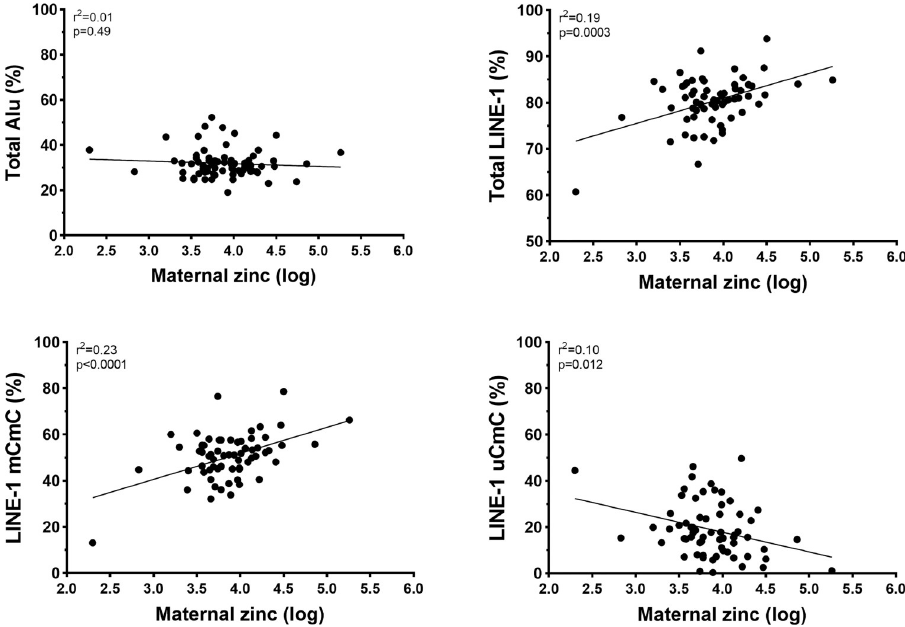
Fig 2. Scatter plots showing linear associations between maternal zinc concentrations in late pregnancy (log- transformed) and methylation levels for total Alu, total LINE-1, LINE-1 mCmC (hypermethylation), and LINE-1 uCmC (partial